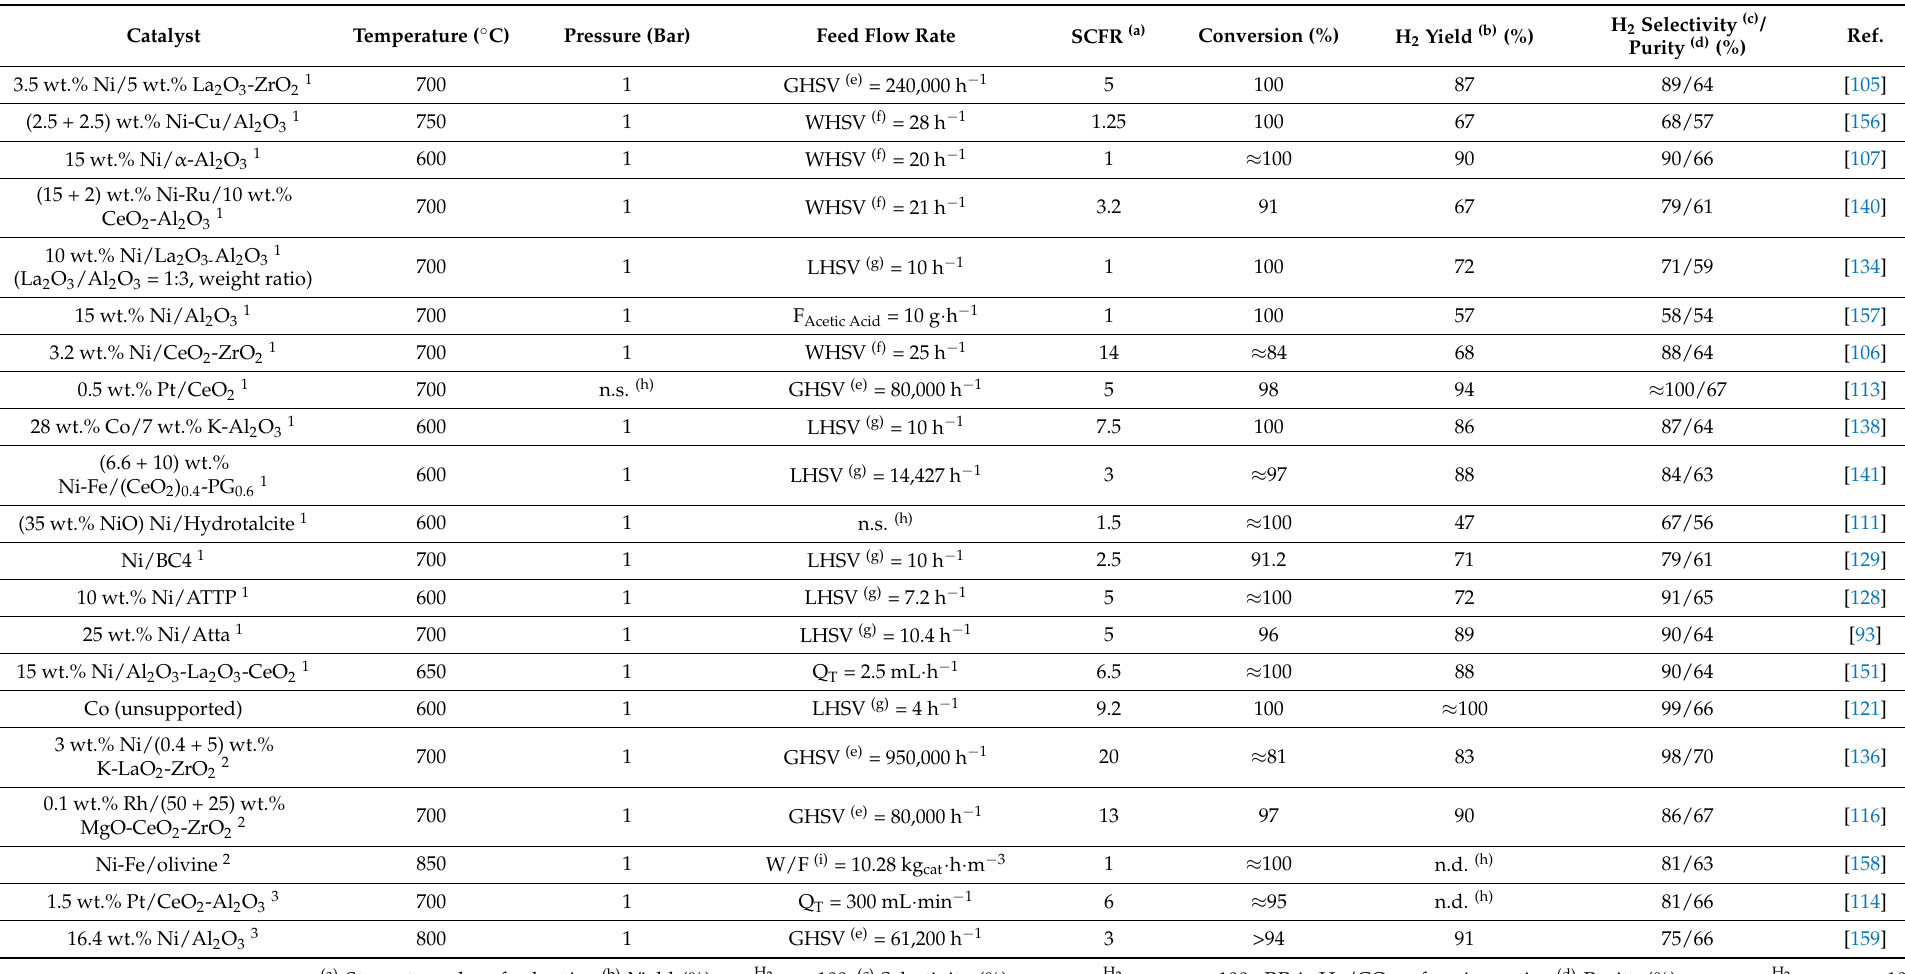
Table 4. Summary of the catalytic performance and operating conditions of catalysts on steam reforming reactions of oxygenated